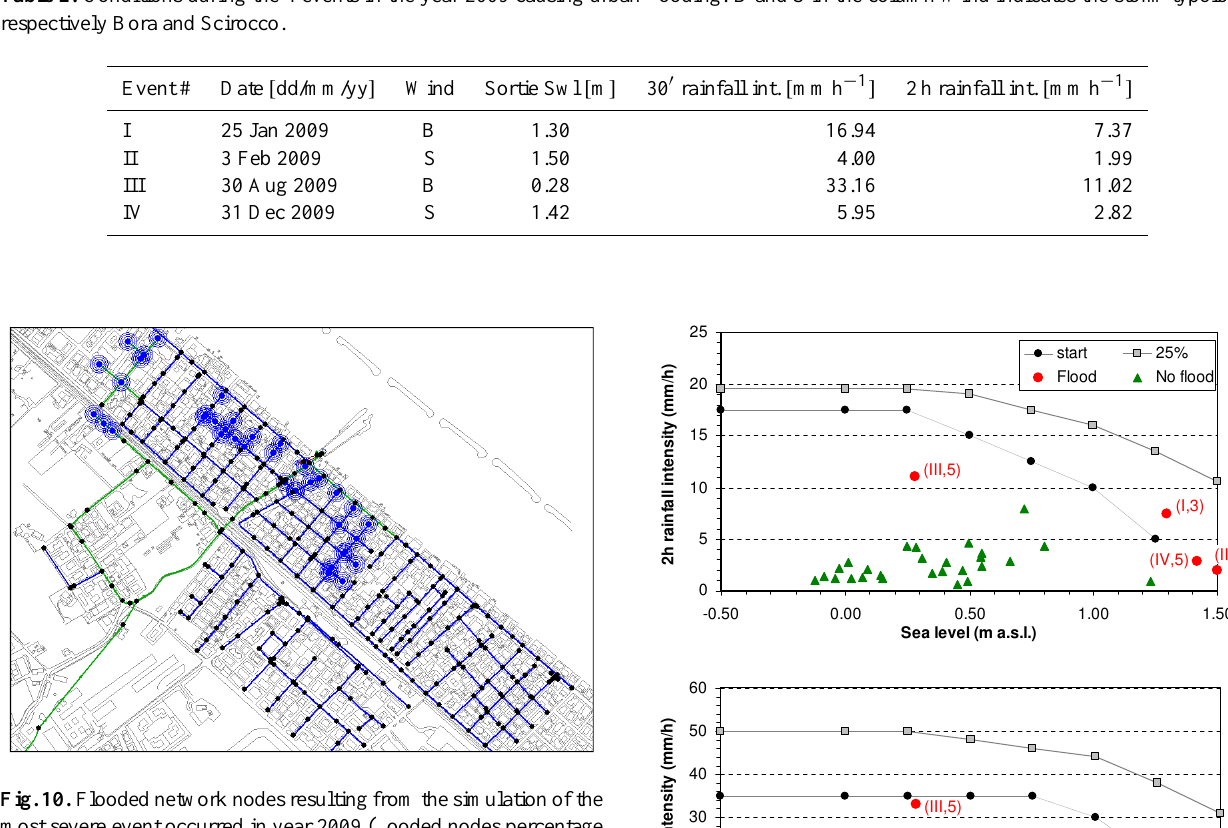
Fig. 10. Flooded network nodes resulting from the simulation of the most severe event occurred in year 2009 (flooded nodes percentage equal to 9%) (Data 3 February 2009, swl=1.50 m, 30’ rainfall in- tensity=4mmh − 1 , 2h rainfall intensity=2mmh − 1 ).